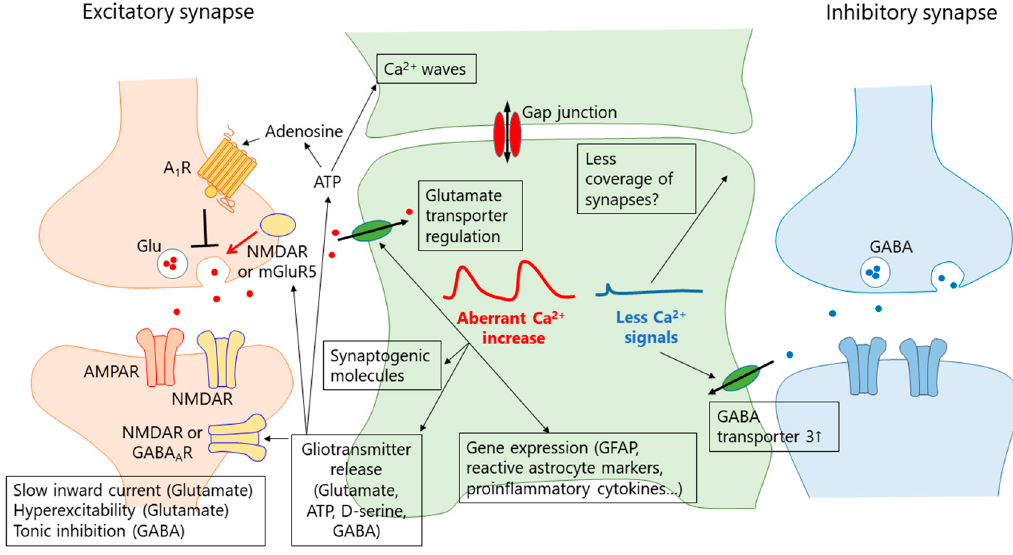
Figure 1. Functional significance of astrocyte Ca 2+ signals in disease. The cartoon indicates how alteration of astrocyte Ca 2+ in disease affects excitatory/inhibitory synapses and excitability of neurons.